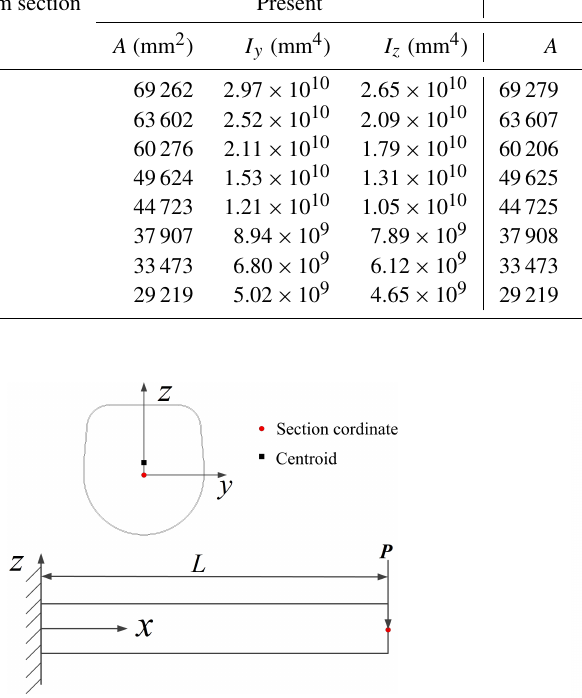
Figure 10. Cantilever beam model.